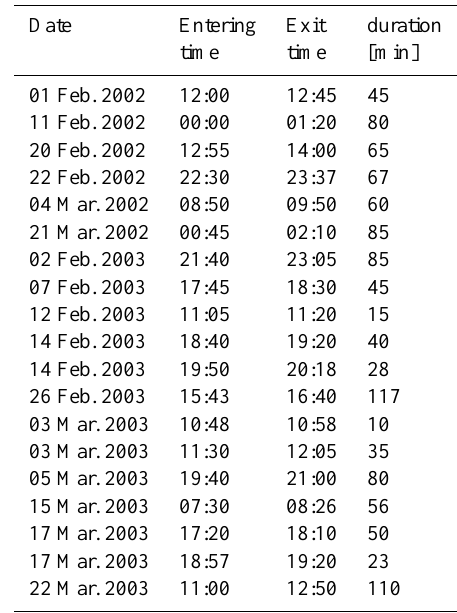
Table 1. A list of the times when Cluster 4 observed the exterior cusp.